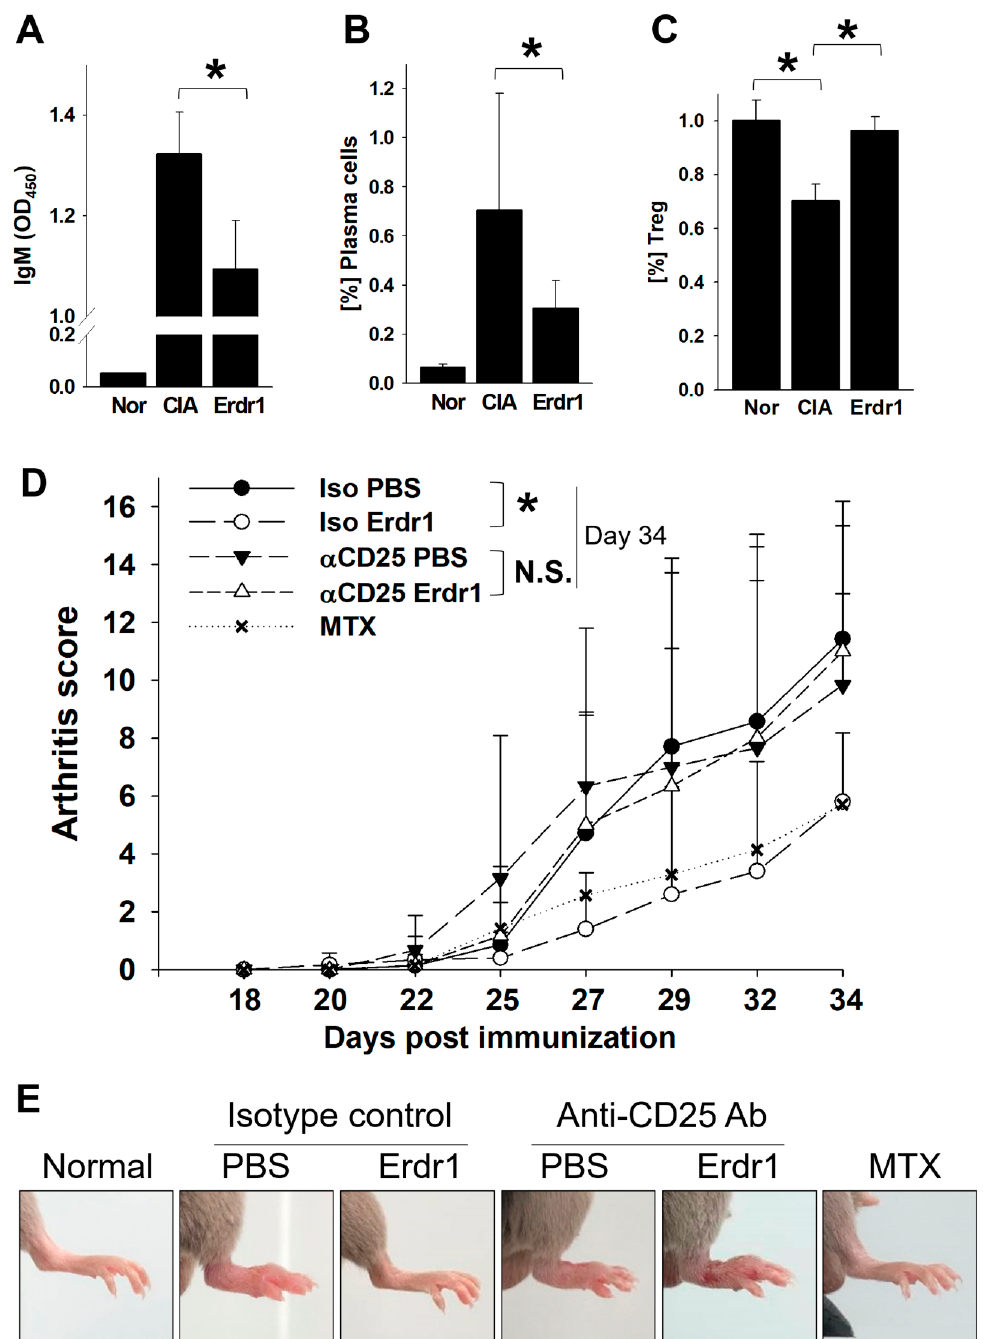
Figure 1. Regulatory T (Treg) cells mediate the therapeutic effects of Erythroid differentiation regulator 1 (Erdr1) on the collagen-induced arthritis (CIA) model. The CIA model was established as described in Materials and Methods. ( A ) Levels of CII-specific IgM were examined from plasma after 1 week of Erdr1 treatment using ELISA. The population of CD138 + plasma cells ( B ) or Treg cells ( C ) in draining lymph nodes from mice treated with Erdr1 for 3 weeks was evaluated by flow cytometric analysis. ( D , E ) Fourteen days after the first immunization of the CIA model, Treg-depletion antibody or isotype-control antibody was injected (250 mg/mouse), and mice were boosted with 6 h interval. One day after boosting, PBS, Erdr1 (0.1 mg/kg), or methotrexate (MTX, 1 mg/kg) was administered (i.p., 3 times/week) for 3 weeks. Arthritis score ( D ) and joint swelling ( E ) were compared from the Treg-depleted CIA mice. Eight mice per group were used for the RA model study. * p < 0.05.